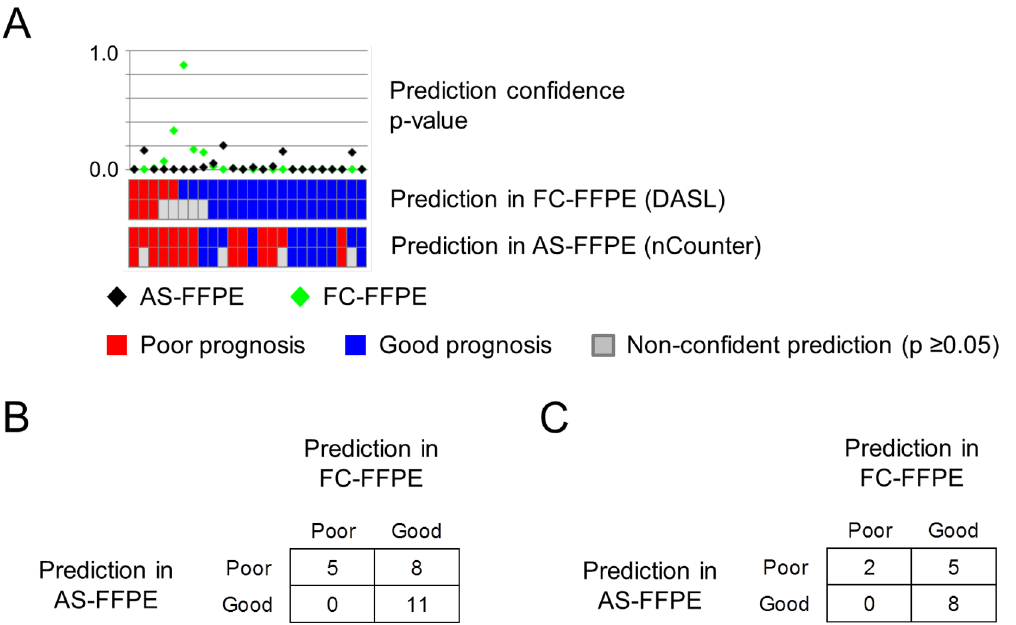
Figure 7. Comparison of transcriptome-based prediction of cirrhosis prognosis between FC-FFPE DASL and AS-FFPE nCounter profiles generated on the same tissue blocks (n=24). (A) Cirrhosis prognosis prediction result for each sample. (B) Contingency table of prediction results comparing FC-FFPE and AS-FFPE. (C) Contingency table of prediction results in 13 samples with statistically more confident prediction (prediction confidence p-value , 0.05). AS: archived section, FFPE: formalin-fixed paraffin-embedded, FC: freshly cut.